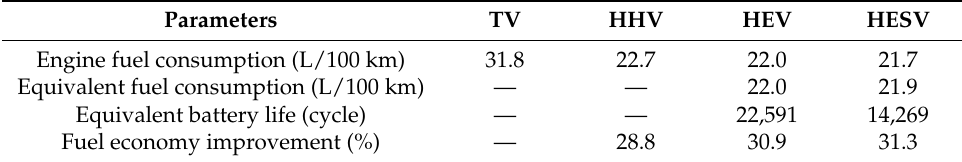
Table 5. Simulation results of the four vehicles under the Chinese urban bus cycle (CUBC).